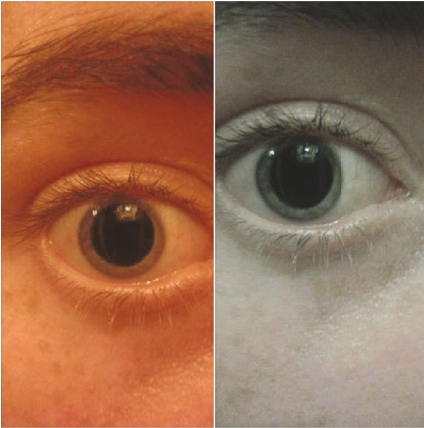
Figure 1: Dilated right pupil of a female psychedelics’